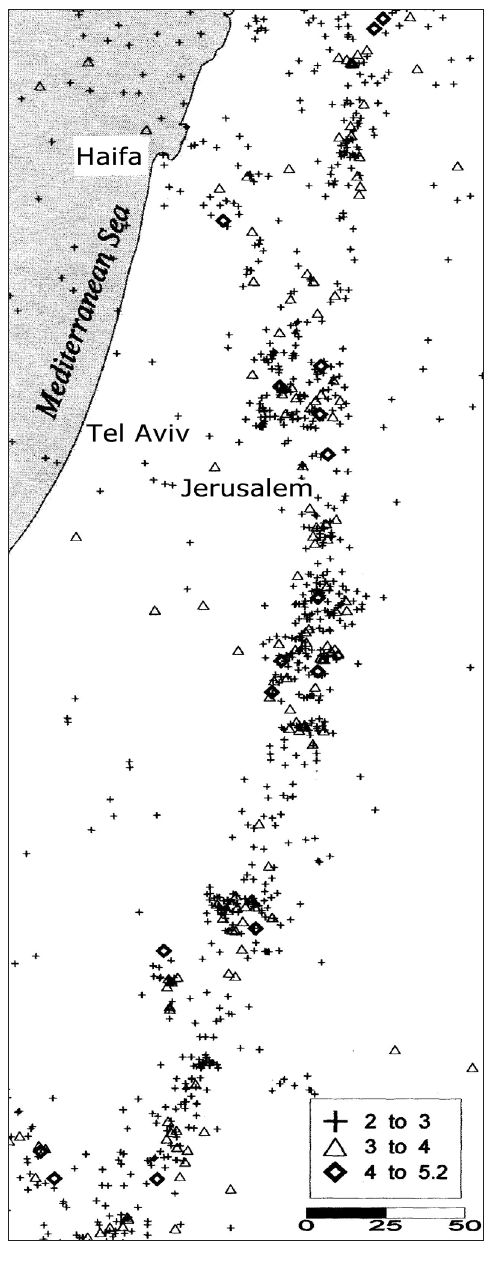
Fig. 2. Seismicity of Israel from 1984 to 2002 (Is- rael Geophysical Institute, Seismological Division,